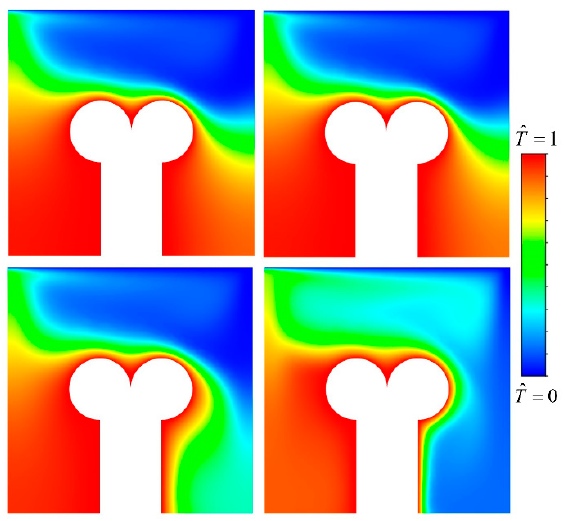
Figure 7. Temperature contours for the C2 fin with Re = 100 for varying Rayleigh numbers. From left to right, top to bottom: Ra = 10 3 , Ra = 10 4 , Ra = 10 5 , and Ra = 10 6 .